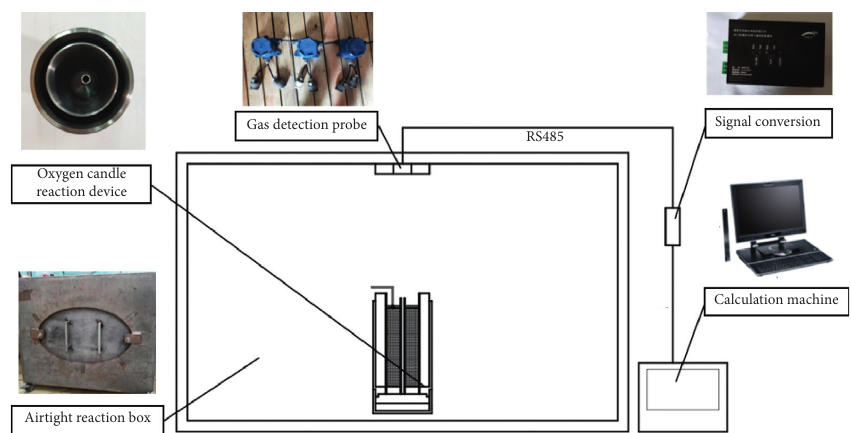
Figure 3: Connection diagram of the oxygen candle oxygen test equipment.